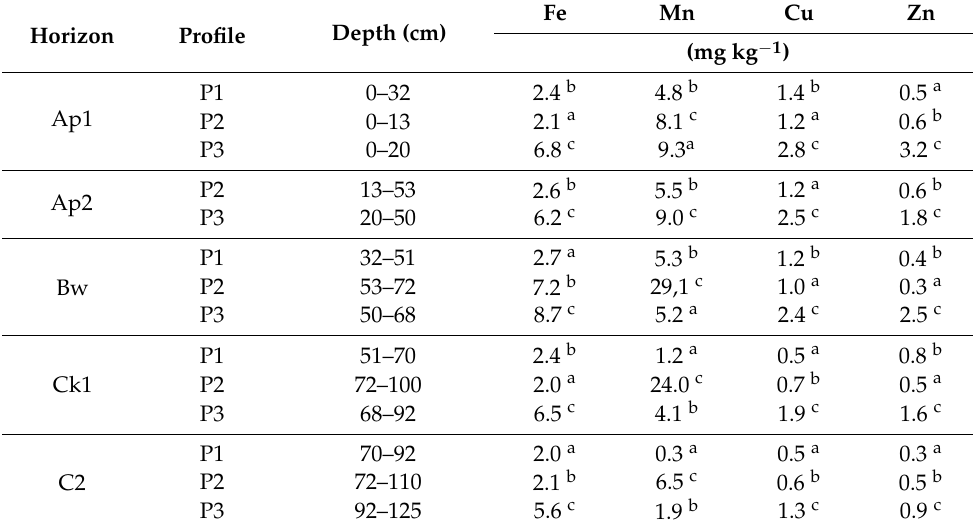
Table 4. Available microelements (Fe, Mn, Cu, Zn) in P1, P2, and P3 horizons.